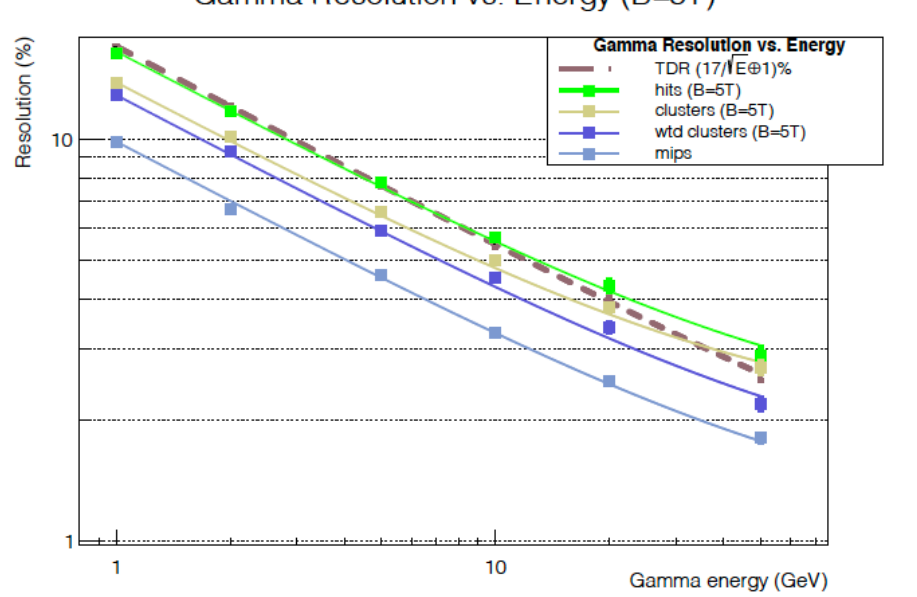
Figure 8. Energy resolution for gamma showers as a function of energy. The curves show (from lower up) the resolution based on counting minimum ionizing particles (light blue, MIPs), modified cluster counting (dark blue), pure simple cluster counting (light brown), active pixels (green, Hits), and the required performance from the ILC TDR (brown